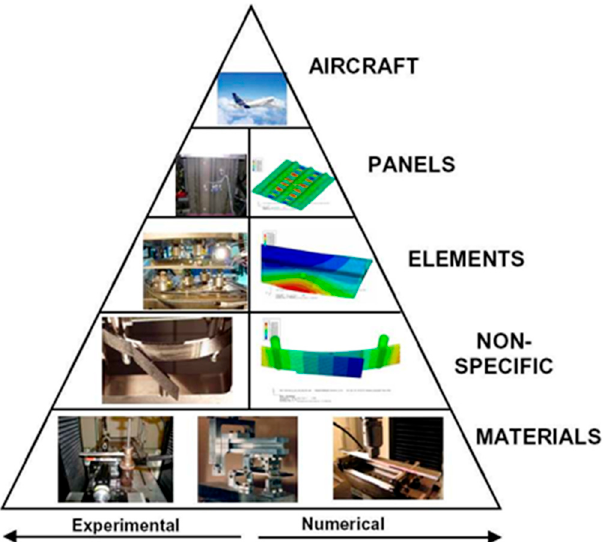
Figure 1. Pyramid of test from Rouchon [1] adaptated by Bertolini et al. [2] focusing on stiffened panels and the experiment-simulation duality.